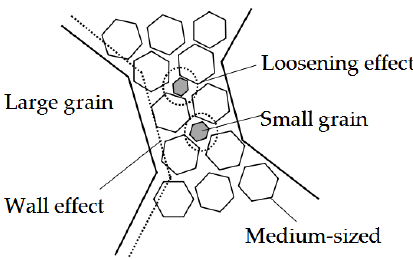
Figure 4. The wall effect and loosening effect on the packing density of grains [23,24].